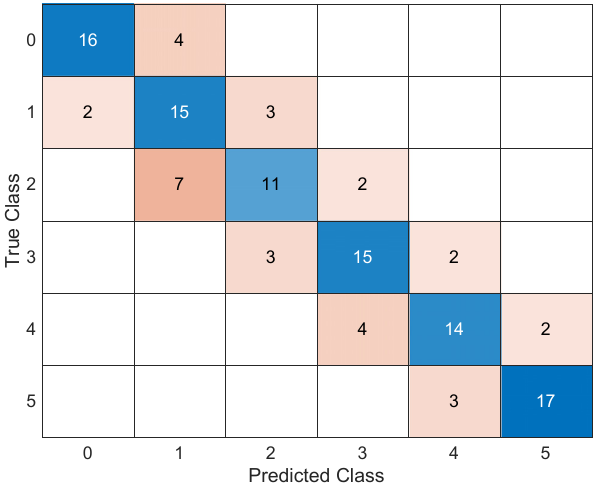
Figure 8. Confusion matrix.